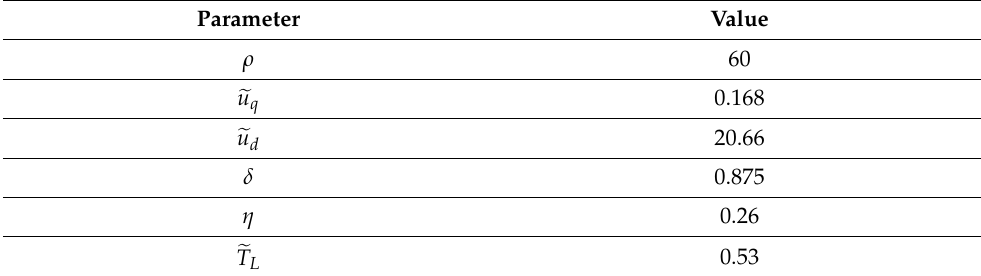
Table 1. BLDCM system parameters